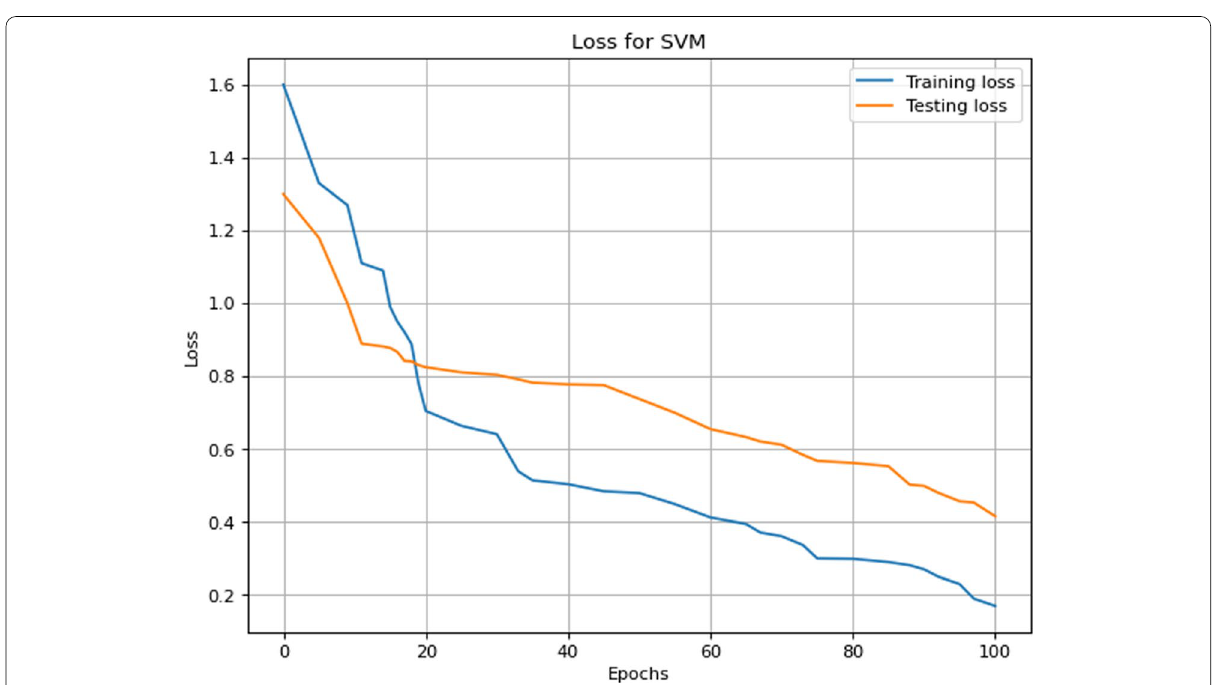
Fig. 19 Loss for our proposed model with